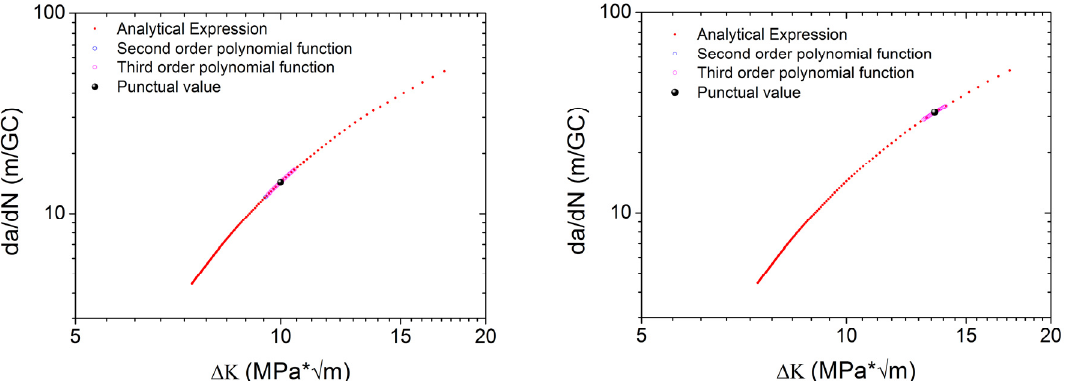
Figure 12: Crack propagation curves, local interpolation ranges and crack growth rate values.